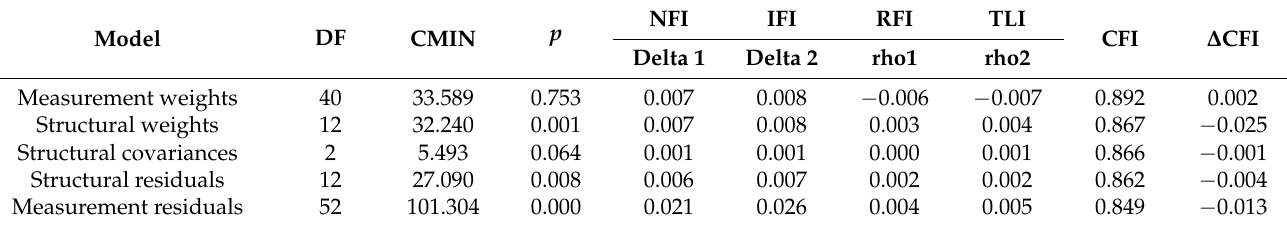
Table 8. Comparison of structural models without deformation for different grade